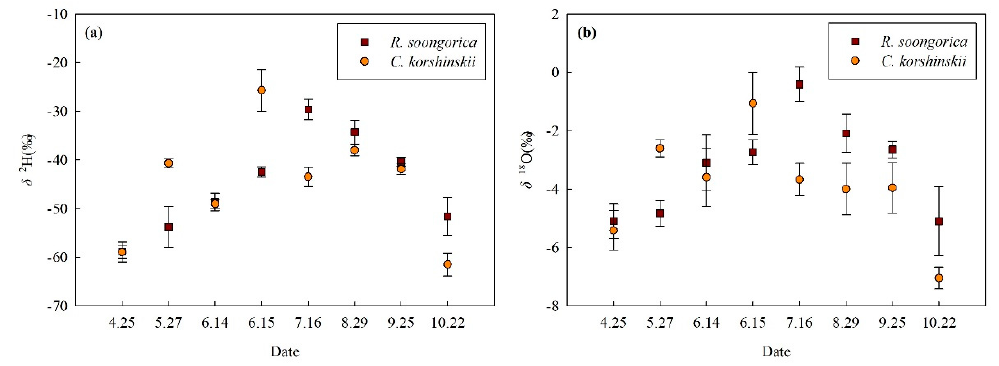
Figure 6. Seasonal isotopic variations of ( a ) δ 2 H and ( b ) δ 18 O xylem water in C. korshinskii and R. soongorica . (Mean ±S.D., N = 4).